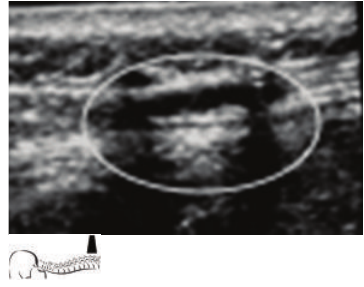
Figure 5: Longitudinal view at the lumbar spine. Visualization of the local anesthetic spread confirmed the